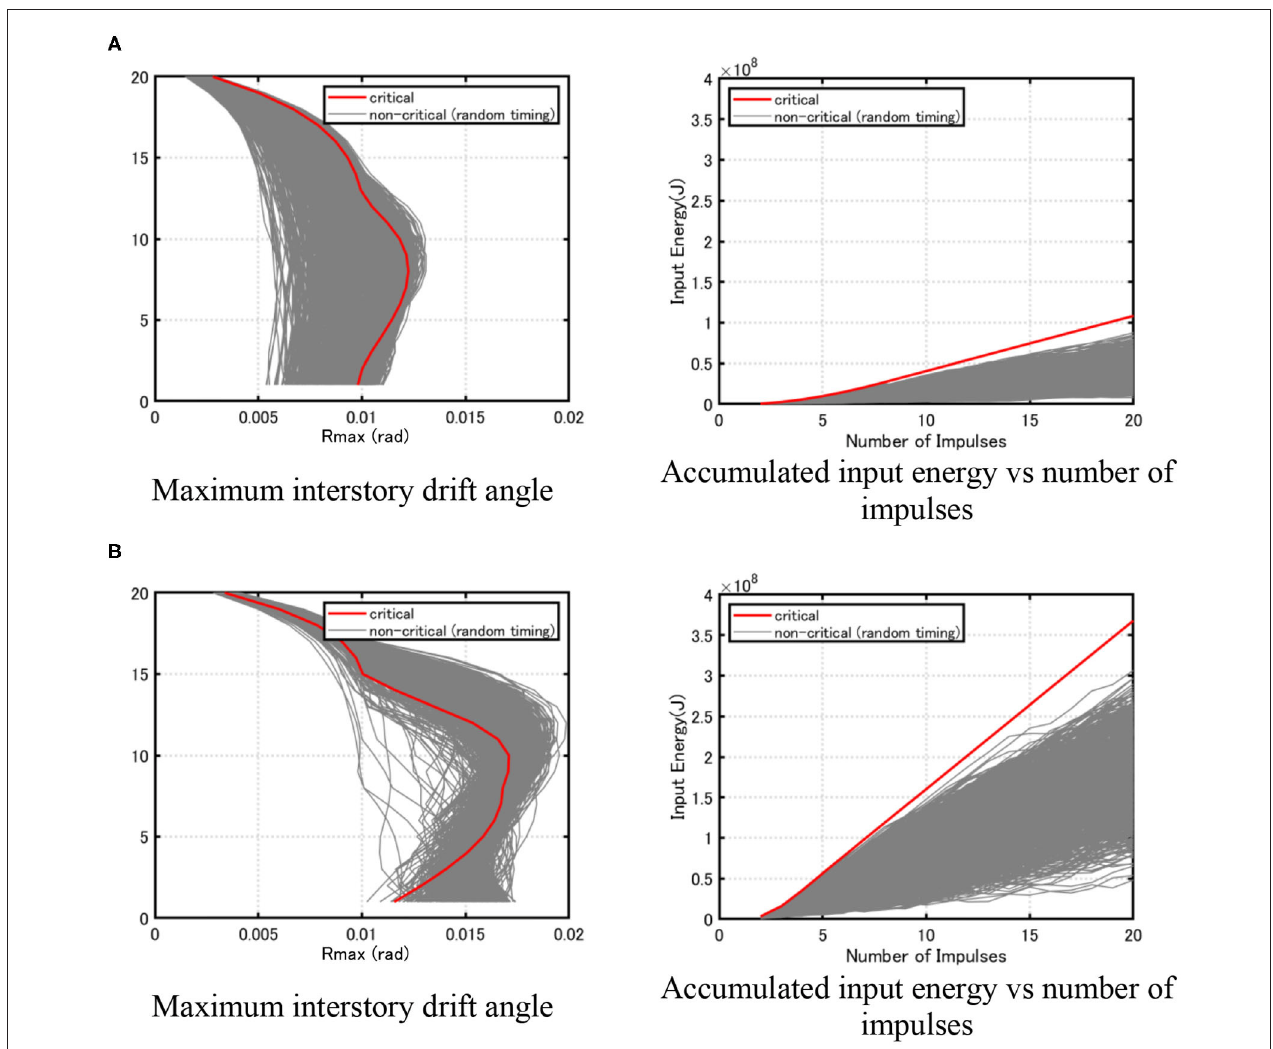
FIGURE 5 | Maximum interstory drift angle distribution and accumulated input energy under critical input and various non-critical inputs for 20-story building model. (A) V MI / V y = 2.0, (B) V MI / V y =